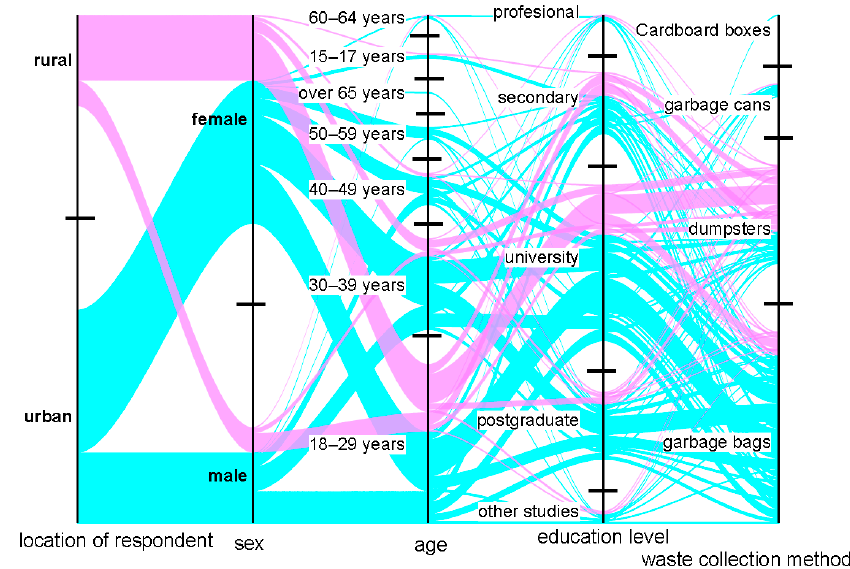
Figure 2. Distribution of the results obtained through the questionnaire. Table 1. Table indicating the studied parameters’ frequency analysis by classes, amount and waste collection method.